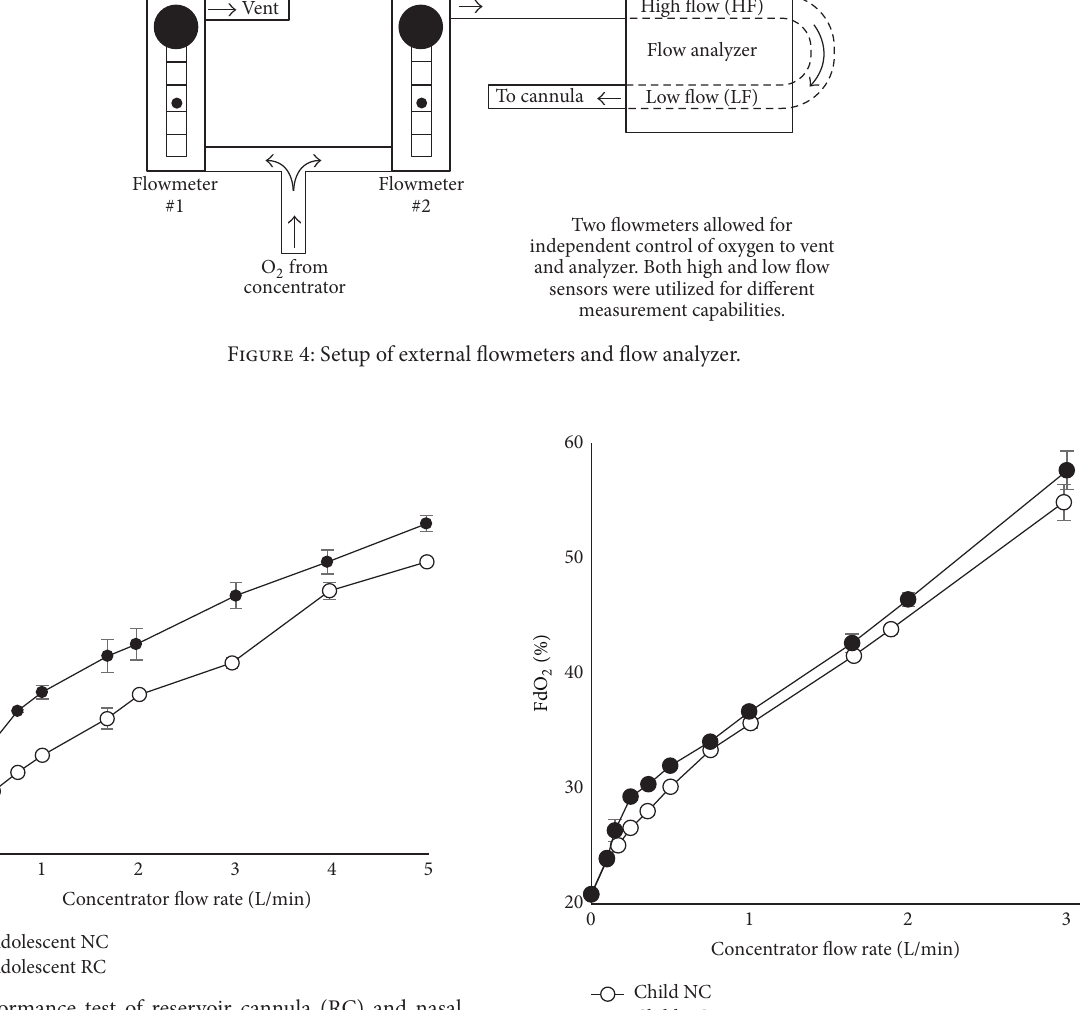
Figure 5: Performance test of reservoir cannula (RC) and nasal cannula (NC) on the adolescent lung model.